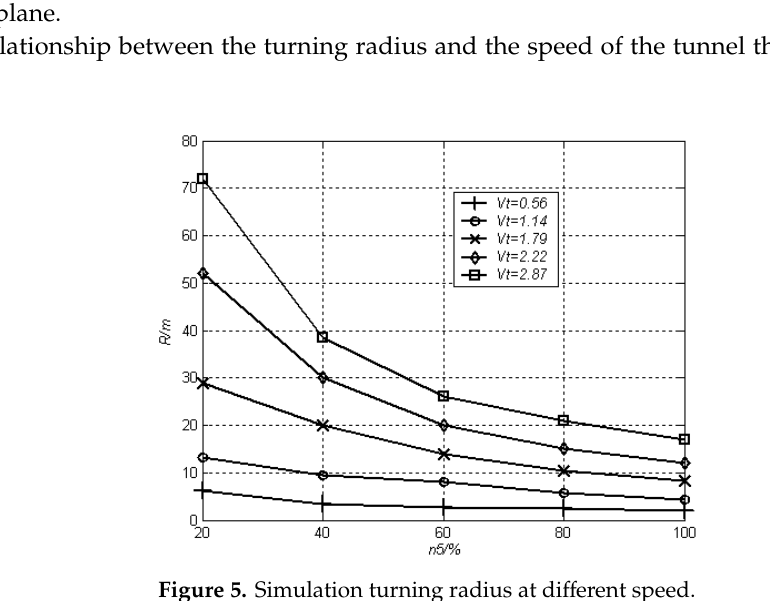
Figure 5. Simulation turning radius at different speed.